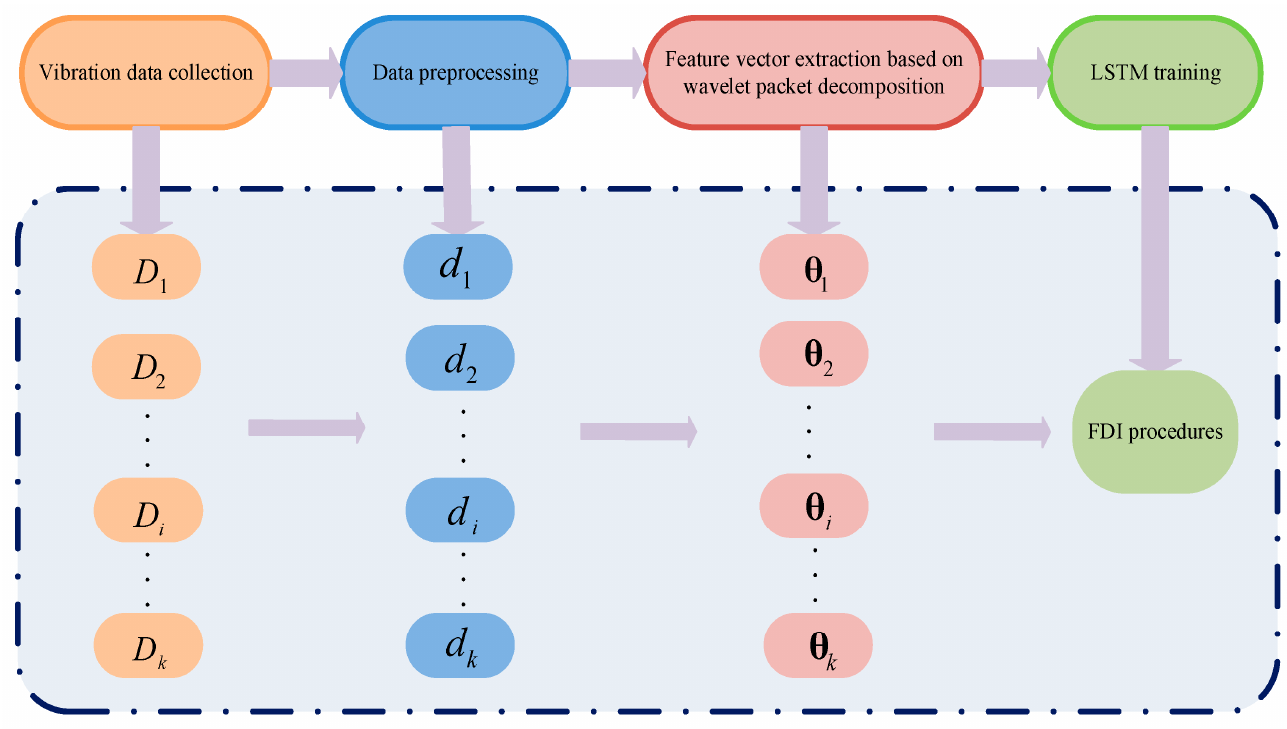
Figure 6. Recorded quadcopter FDI method algorithm [53], used with permission under Creative Commons Attribution 4.0 International License.